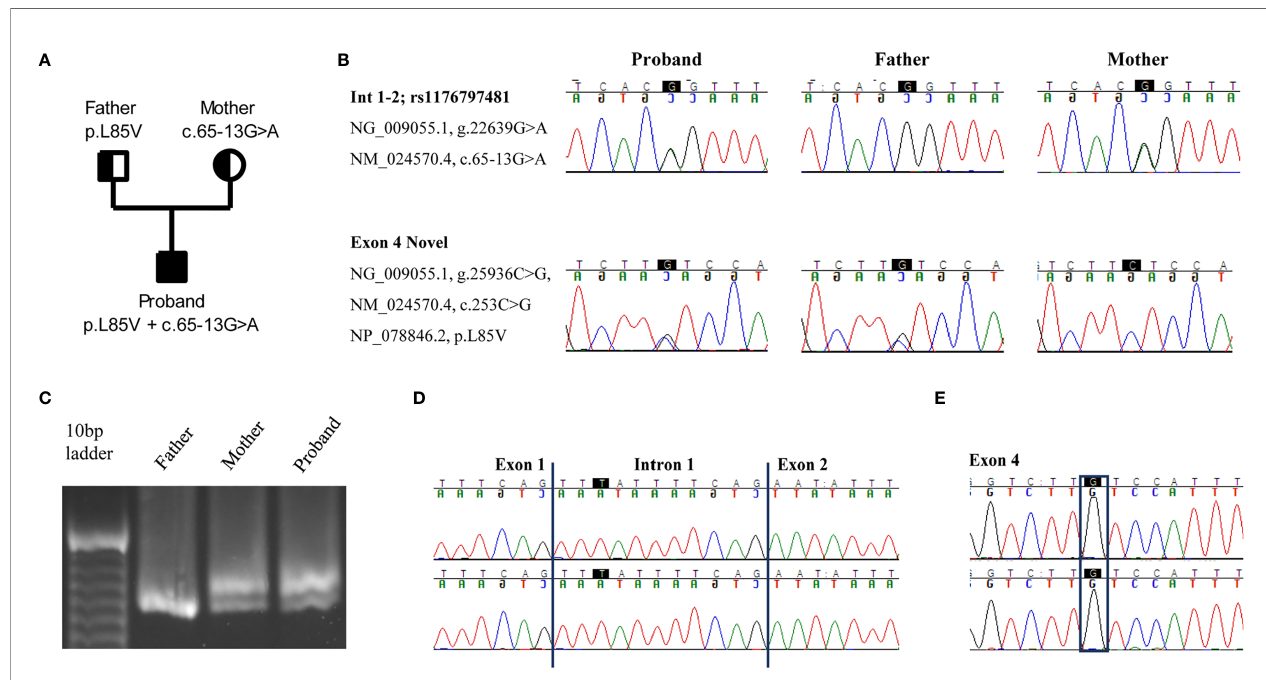
FIGURE 1 | An intron variant and a novel missense mutation in RNASEH2B gene are identi fi ed. (A) Pedigree of the family. Squares and circles represent male and female family members, respectively. (B) The two variants c.65-13G>A and c.253C>G are con fi rmed in the proband and parents by Sanger sequencing. (C) cDNAs from the proband and his parents were resolved on a 3% agarose-gel, showing the different splice variants. (D, E) Electropherograms of the two splice variants identi fi ed in the proband. The highest peak presents an intron retention due to the c.65-13G>A mutation whereas the lowest one the c.253C>G